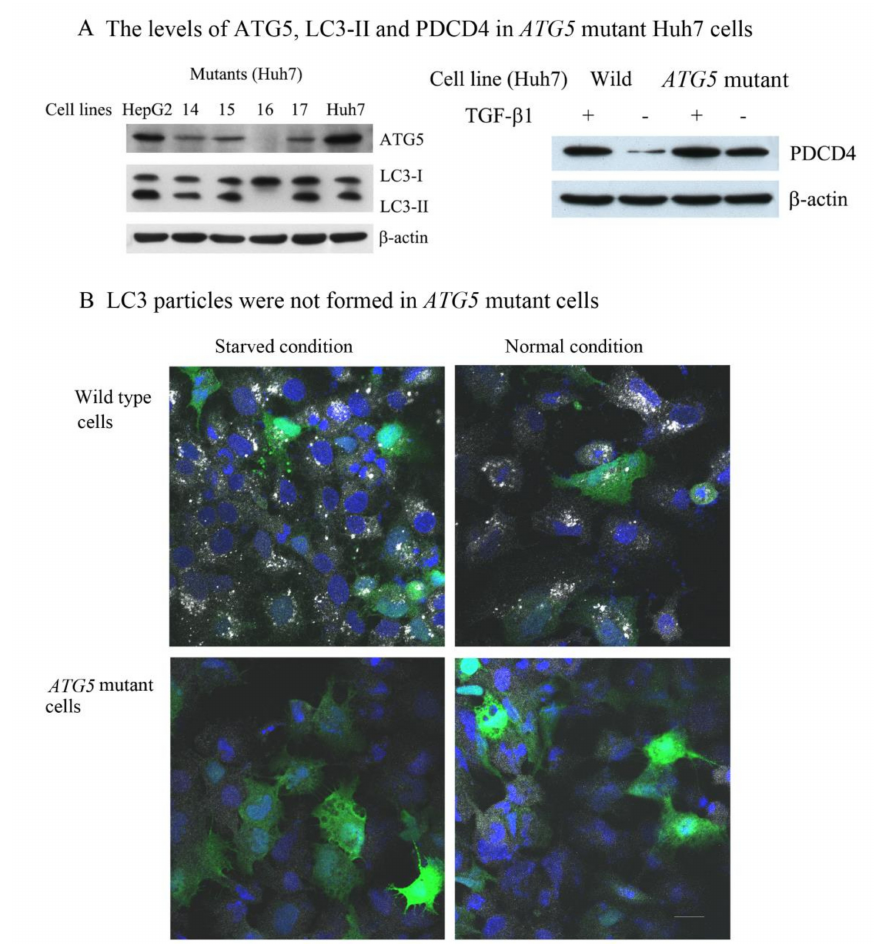
Figure 3. Characterization of ATG5 mutant Huh7 cells ( A ) Left panel: the mutant 16 ( ATG5 -16) was unable to synthesize ATG5 and LC3-II molecules. Right panel: the PDCD4 levels were higher in the ATG5 mutant cells than in the wild-type cells, and the expression of this protein in both cell lines was increased by treatment with 20 nM TGF β 1. ( B ) The formation of LC3 particles in wild-type and ATG5 mutant cells. Both cell lines were transfected with GFP-PDCD4 plasmid and stained with anti-LC3 antibody (white color). The green and blue colors indicate ectopic GFP-PDCD4 and the nucleus, respectively. Particles of LC3, an autophagosome marker, were seen even under normal culture conditions and were further increased under serum-starved conditions in wild-type Huh7 cells. However, these particles were not observed in ATG5 mutant cells, even after autophagy induction by serum